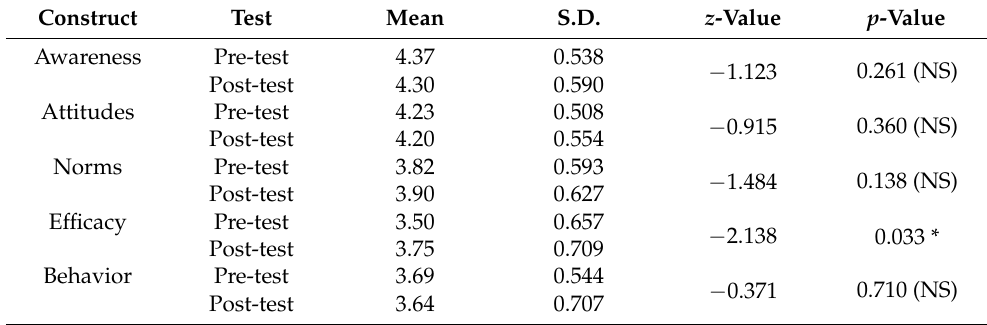
Table 5. Wilcoxon signed-rank tests between pre- and post-test for the Control